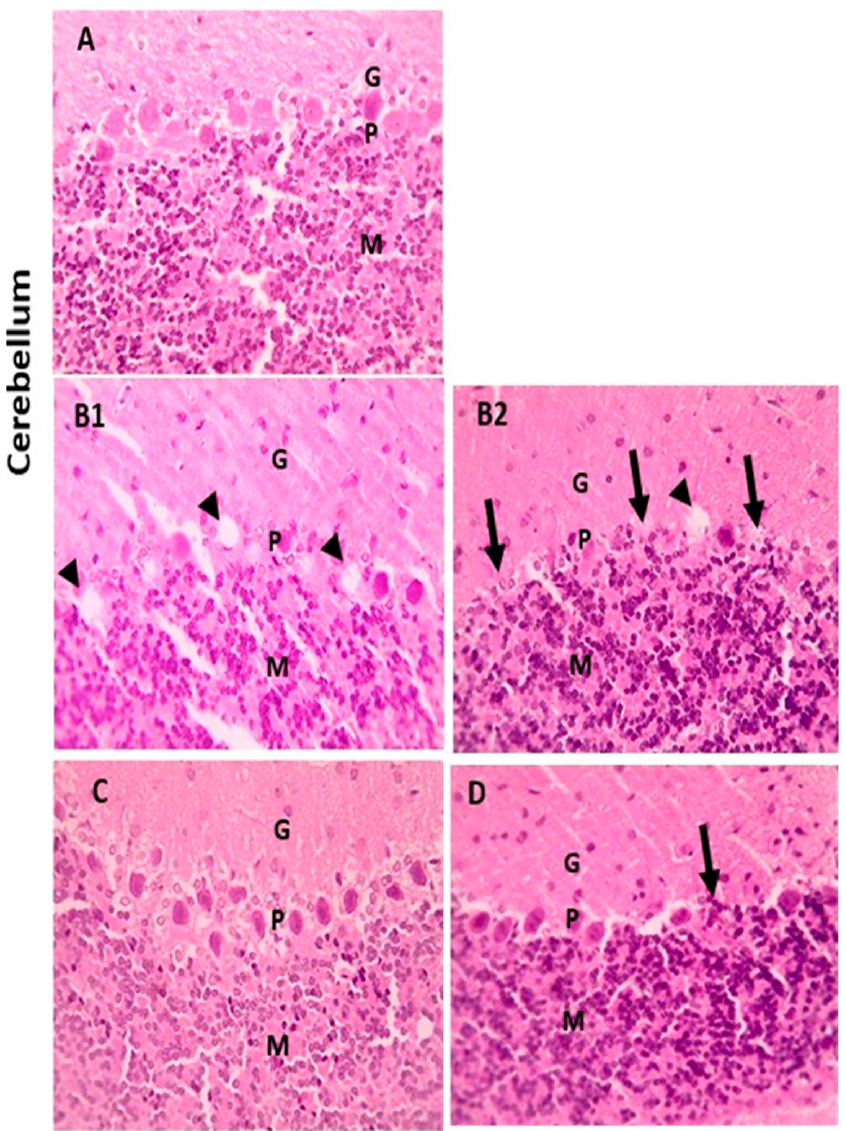
showing marked degeneration and shrinkage of neurons in the pyramidal layer (PL) (H&E, 400 × ). ( D ) Hippocampal section showing mild degeneration and shrinkage of a few neurons in the pyramidal layer (PL) (black arrowheads) (H&E, 400 × ). (G) granular cell layer, (P) Purkinje layer and (M) molecular cell layer.